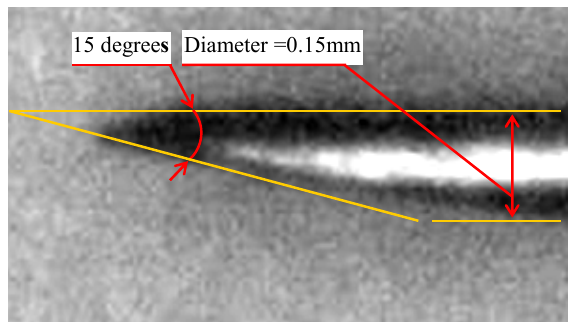
Figure 14. Sample photo of one-face polished edge of a microneedle cut at an angel of 15